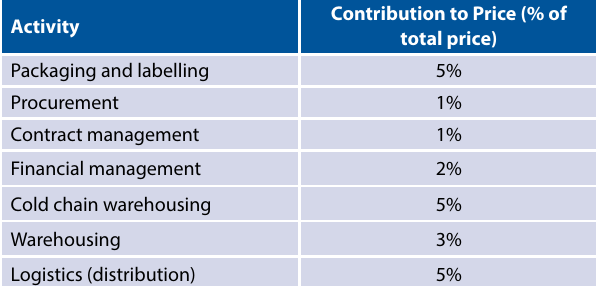
Table 4. Guidelines for contribution to vaccine price per activity Activity